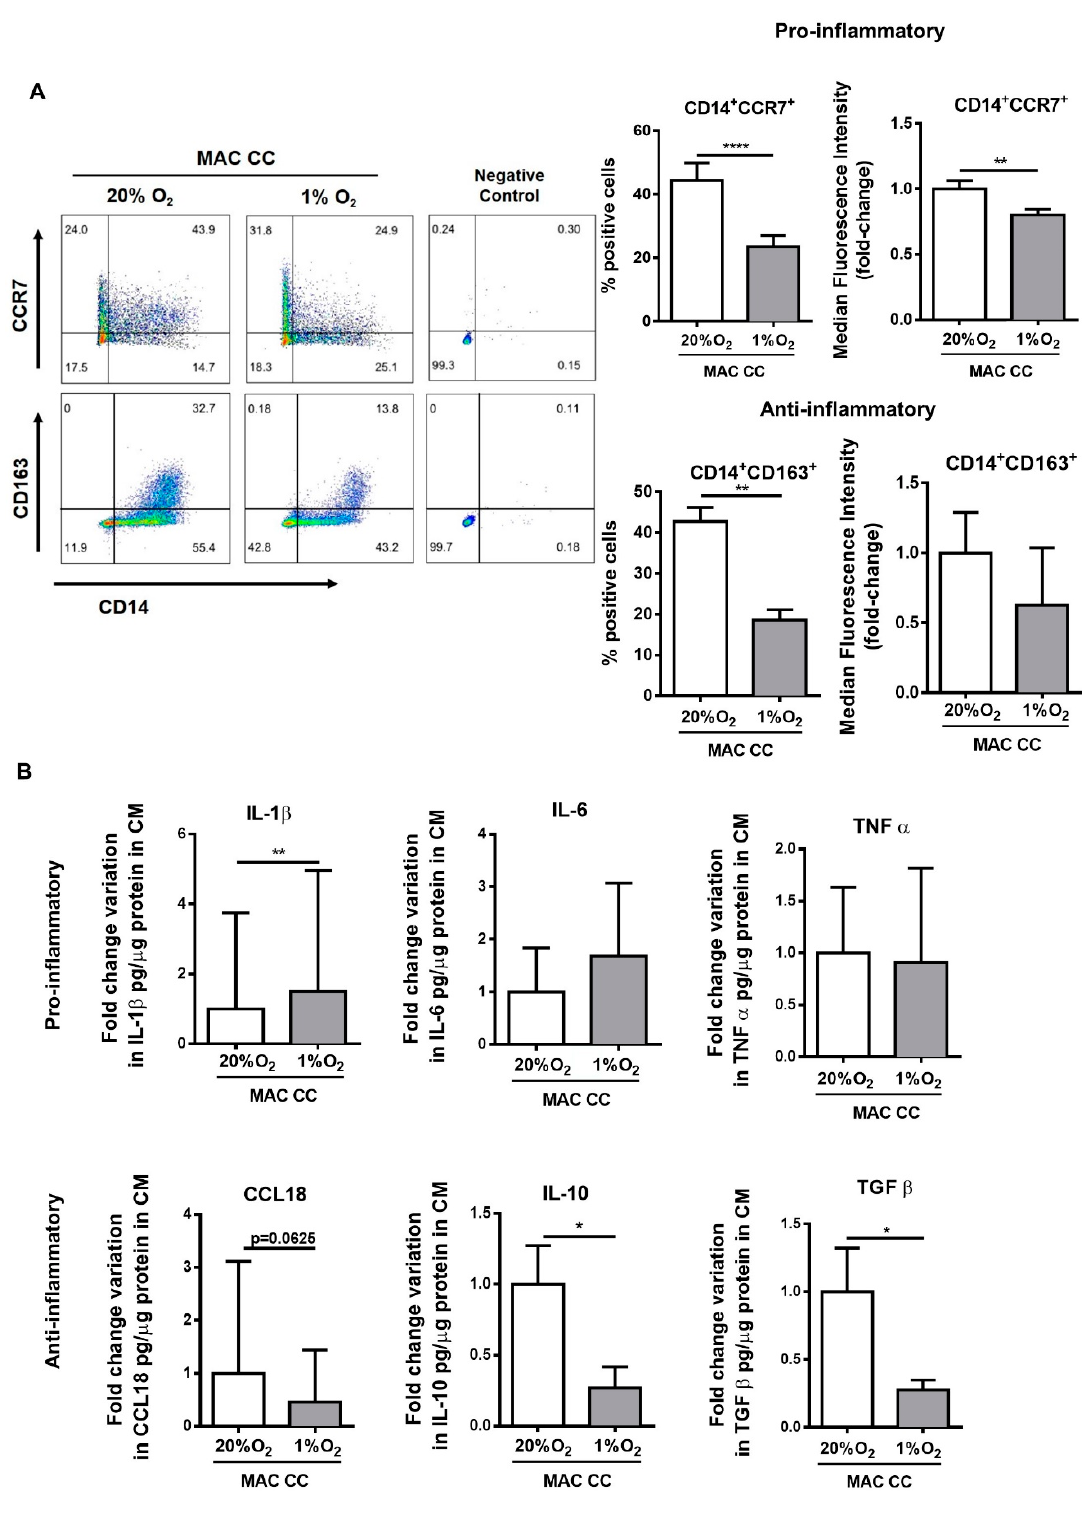
Figure 4 . Hypoxia decreases the anti-inflammatory pressure and increases IL-1 β secretion. Macrophages were indirectly co-cultured with RKO (MAC CC), at 20% or 1% O 2 for 72 h. ( A ) Expression of CD14 and of the polarization markers CCR7 and CD163 was evaluated on macrophages by flow cytometry. Pseudo-color plots display the gating strategy for flow cytometry. Graphs represent the percentage and median fluorescence intensity, which is presented as fold-change relatively to 20% O 2 condition. ( B ) Concentration of secreted molecules was measured by ELISA, and normalized to conditioned media (CM) protein levels. Graphs represent cytokine concentration of pro- and anti-inflammatory markers, as a fold change variation to macrophages cultured at 20% O 2 . Graphs display the mean values with standard deviations, and are representative of n = 12 (CCR7); n